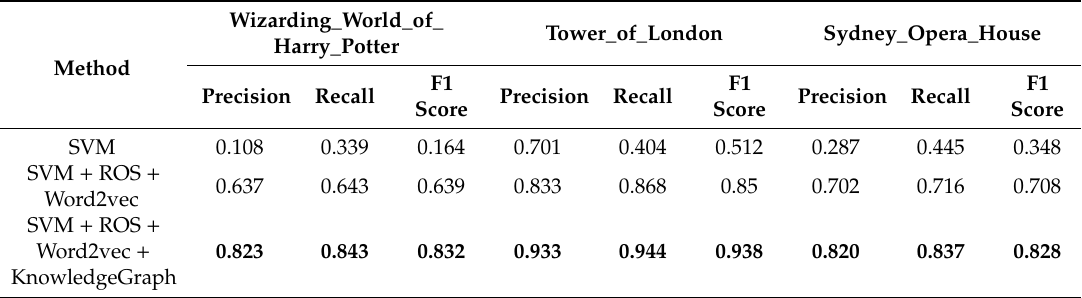
Table 6. Experimental results of the other three data